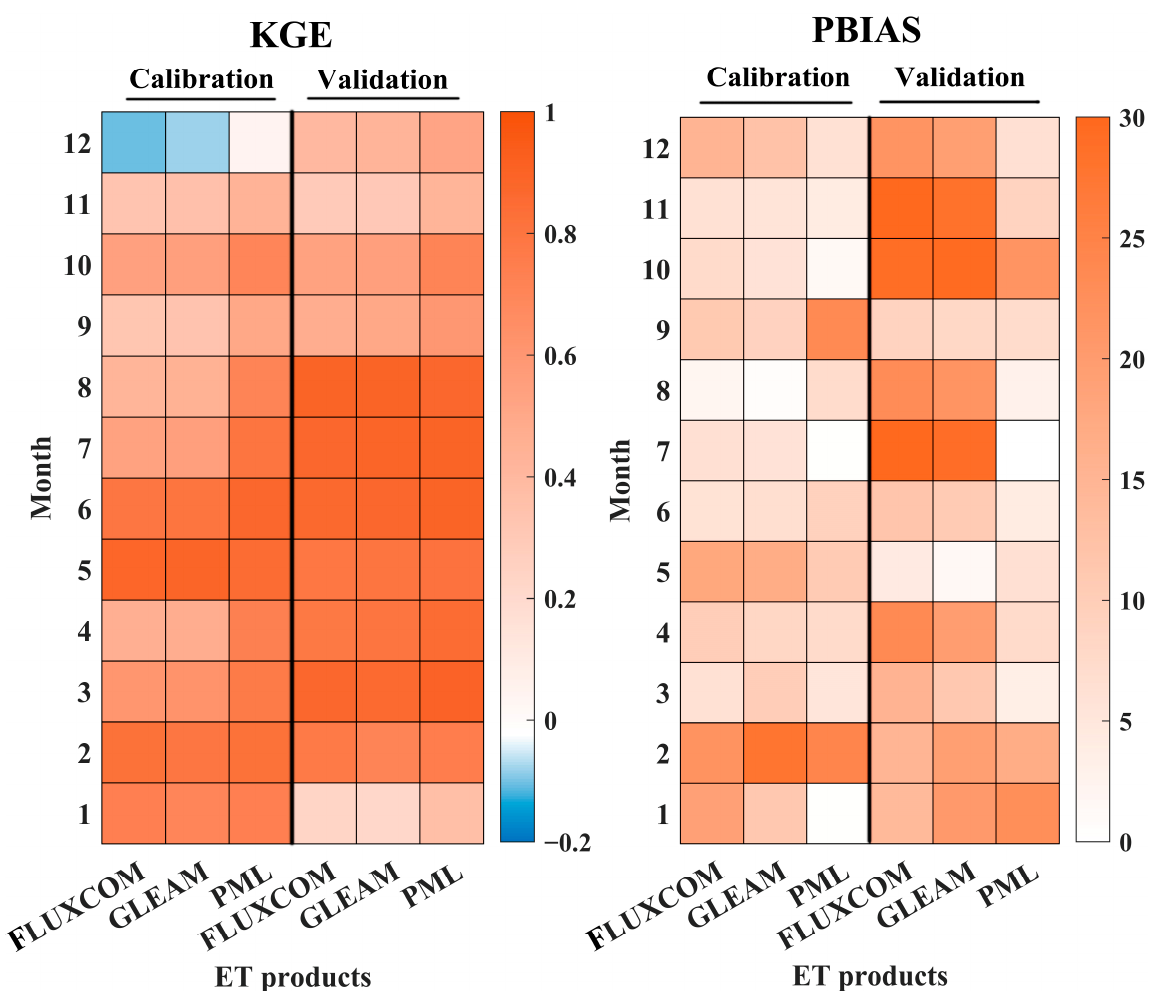
Figure 7. Comparison of KGE and PBIAS values for runoff simulations in different months based on Scheme II.